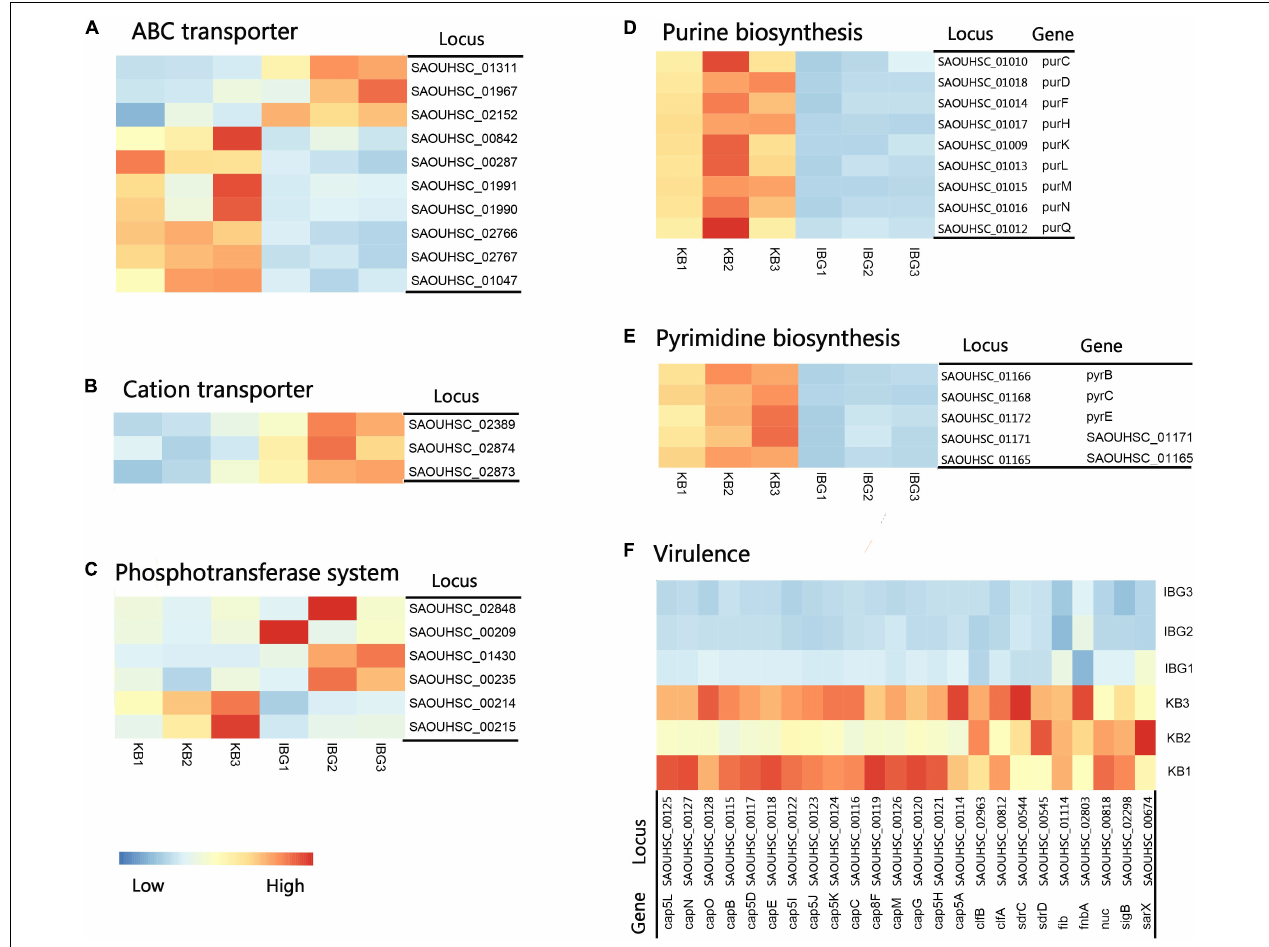
FIGURE 4 | Heat map representation of DEGs involved in main pathways. (A) DEGs related to ABC transporters. (B) DEGs involved in cation transporters; (C) DEGs related to phosphotransferase system. (D) DEGs involved in purine biosynthesis pathway. (E) DEGs involved in pyrimidine biosynthesis pathway. (F) DEGs involved in virulence. All genes represented have a > twofold change in expression treated with IBG relative to their expression in control samples.